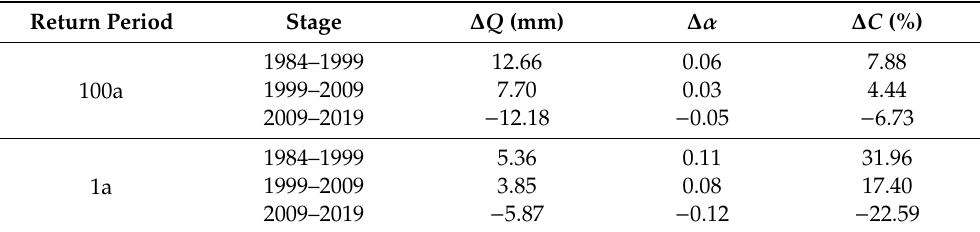
Table 3. Changes in surface runoff parameters at different stages under the rainfall return periods of 1a and 100a.